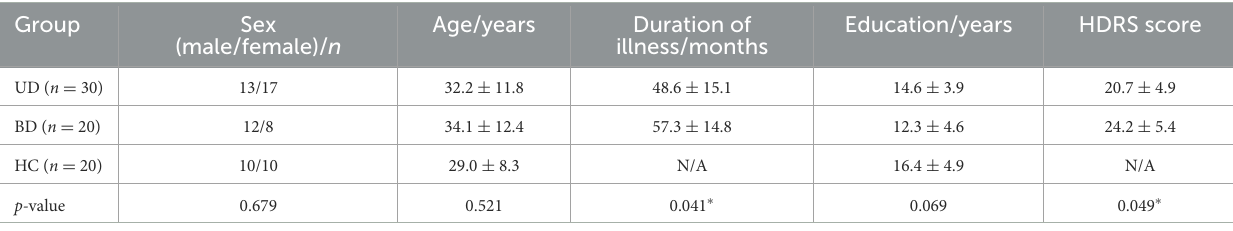
TABLE 1 Demographic and clinical information for the participants by group. Group